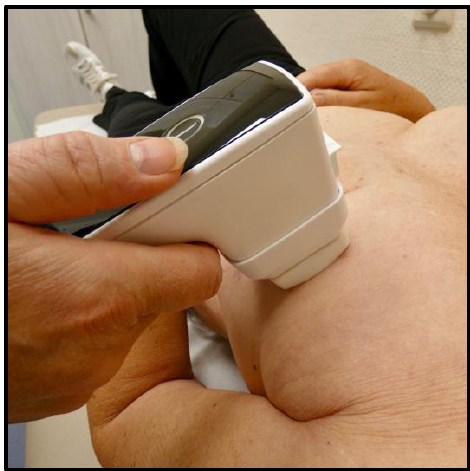
Figure 1. Generation and application of NIPP to the breast. The device is pressed loosely on the skin with a separate 4 × 4 cm spacer for each patient and each visit. NIPP = non-invasive physical